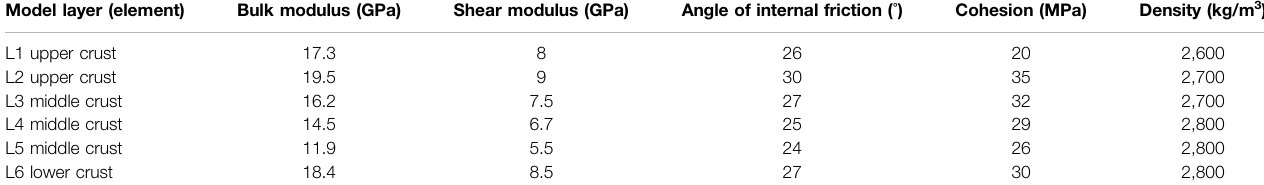
TABLE1| Valuesofthematerialproperties(Mohr – Coulombmodelparameters)assumedforsixlaterallyhomogenousmodellayersattheinitialstageofmodelconstruction, followed by application of “ damage function ” to produce heterogeneous property patterns (see Figures 3 and 4 ). Model layer (element)